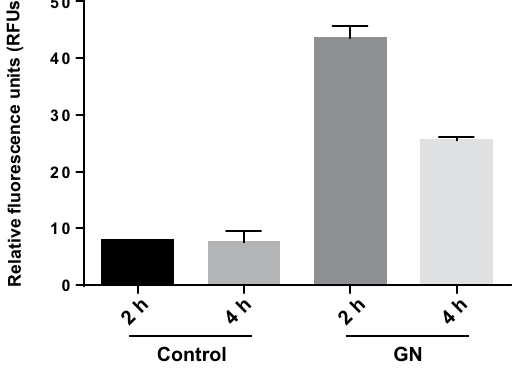
Figure 2. Oxidative stress (ROS) determination of S. cerevisiae cells exposed to 160 mg L − 1 of GN during 2 and 4 hours. The control condition corresponds to non-exposed S. cerevisiae cells. The reported values are the averages of two biological replicates per culture